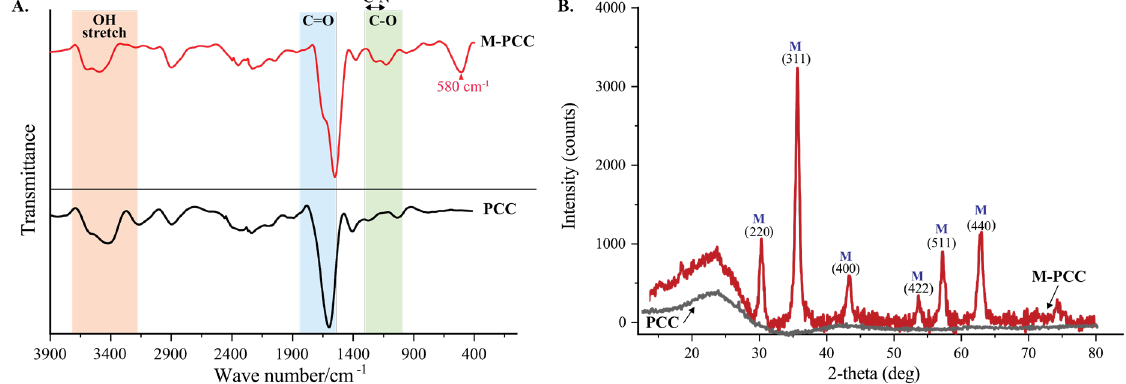
Figure 1: Comparison of the structural features of magnetite nanoparticles impregnated pyrolyzed coconut coir (M-PCC) and activated and pyrolyzed coconut coir (PCC). A: FTIR spectra of the M-PCC and PCC; B: Powder X-Ray diffraction patterns of M-PCC and